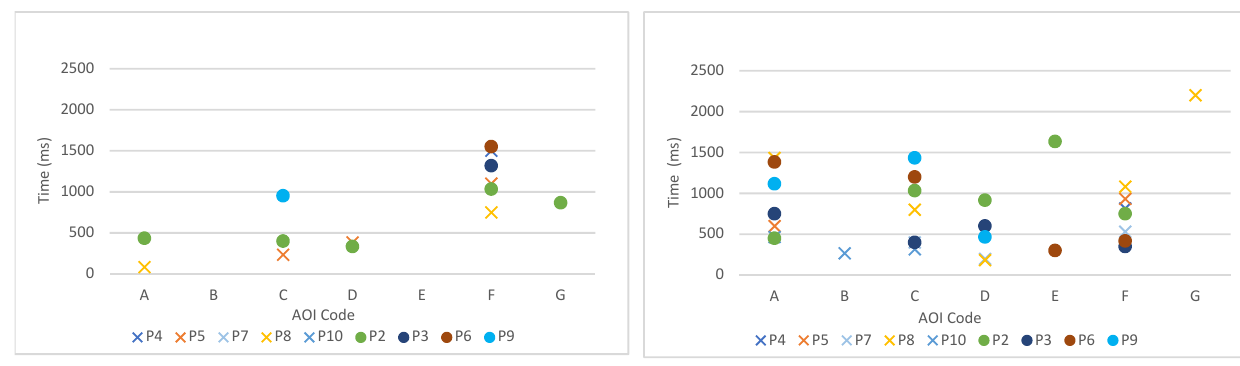
Figure 9. Individual entry time.